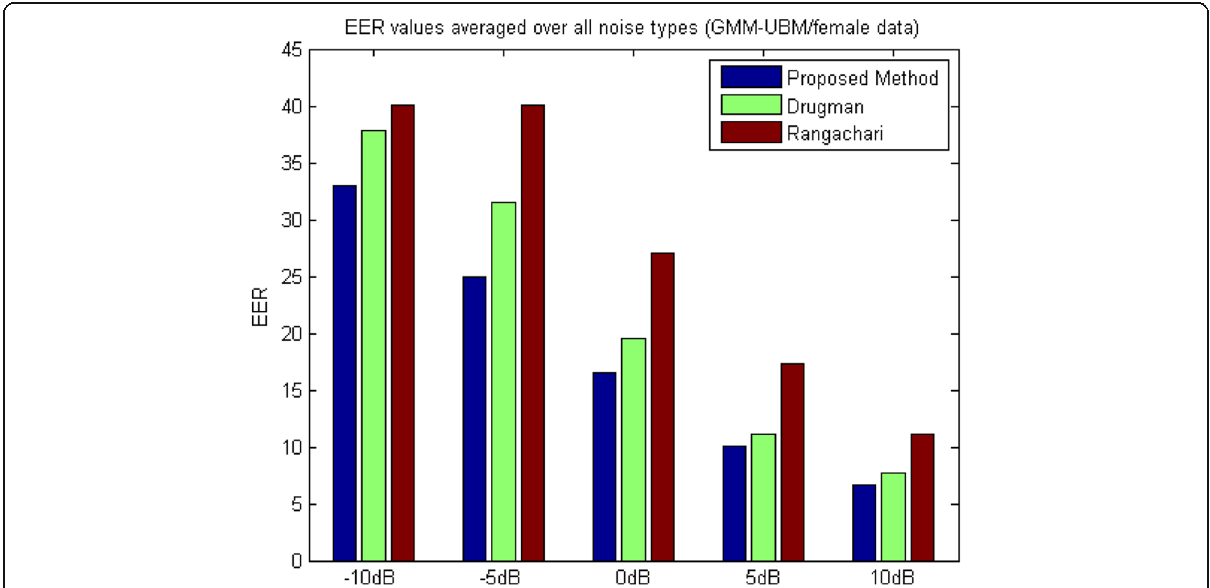
Fig. 8 EER values averaged over all noise types for the female data with GMM/UBM